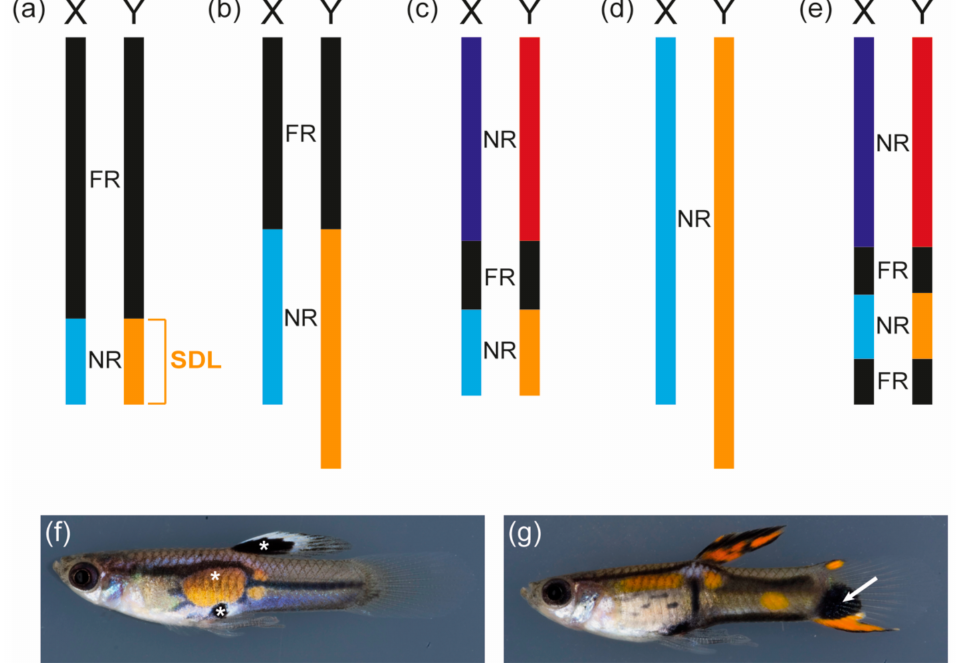
Figure 1. Guppy sex chromosomes. ( a – e ) Schematic representations of guppy sex chromosomes proposed by different studies (blocks only roughly drawn to size). ( a ) Inferred from cross-over frequencies of male pigmentation traits; summarized in 1947 [71]; ( b ) Deduced from cytological evidence in 2001 [85]; ( c ) Derived from the analysis of genetic markers in 2009; no marker in the light blue/yellow NR could be found, which is why the size of this region is unknown [82,83]; ( d ) Based on cytological evidence in 2014; no clear chiasma structure between X and Y could be detected [75]; ( e ) Proposed based on a cytological study in 2015; an ornamental guppy strain was investigated [84]. The distal yellow block contains the male sex-determining locus (SDL) and Y-specific color loci, for instance, maculatus ( f ), pauper, and armatus. The structure of the sex chromosomes varies greatly between guppy populations. ( f ) White asterisks mark the Y-specific maculatus traits described in the text. Total length of the male: 2.4 cm; ( g ) Male with an EnCCFR (Cuman á ) Y-chromosome featuring a black spot (white arrow) in the tailfin, which is associated with a constriction of the X-chromosome. Total length of the male: 2.5 cm. Guppy pictures courtesy of Christine Dreyer. FR (black): freely recombining region; NR (light blue, yellow, dark blue, red): non-recombining region or region with reduced